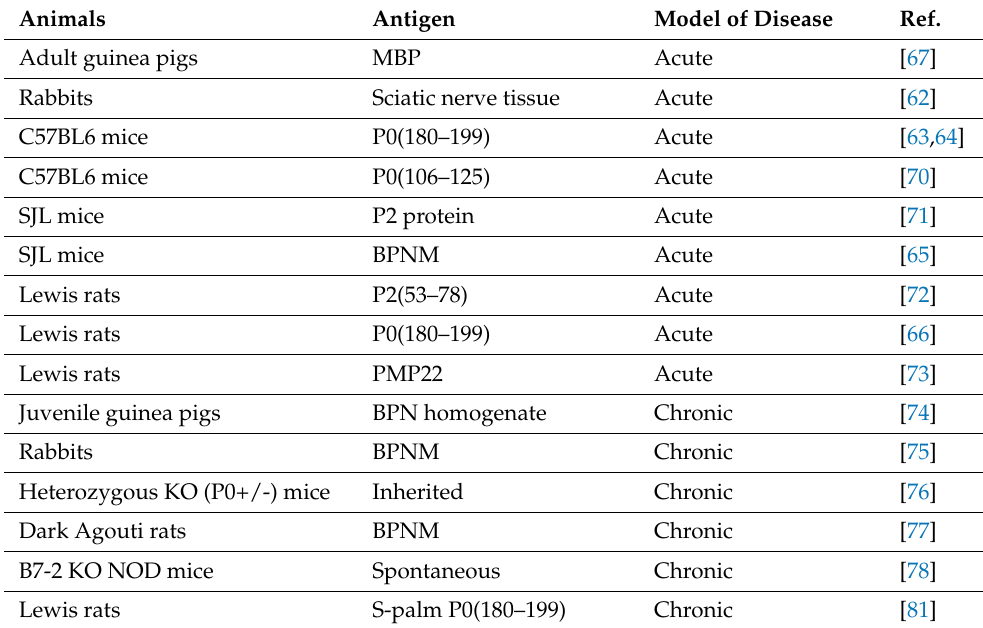
Table 1. Experimental autoimmune neuritis models used to study